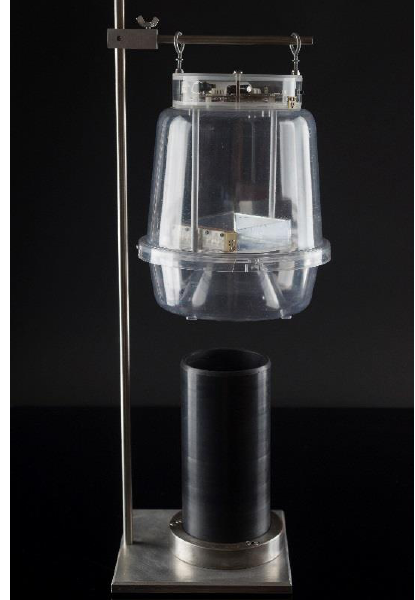
Figure 7. Testing setup. The trap is fixed on the entrance of a dark tube. Fruit flies are placed inside the tube. Insects follow the light at the end of the tunnel and either fly in the trap directly or most commonly, walk until the internal border of the trap and then fly in. Table 2 . Dataset composition.